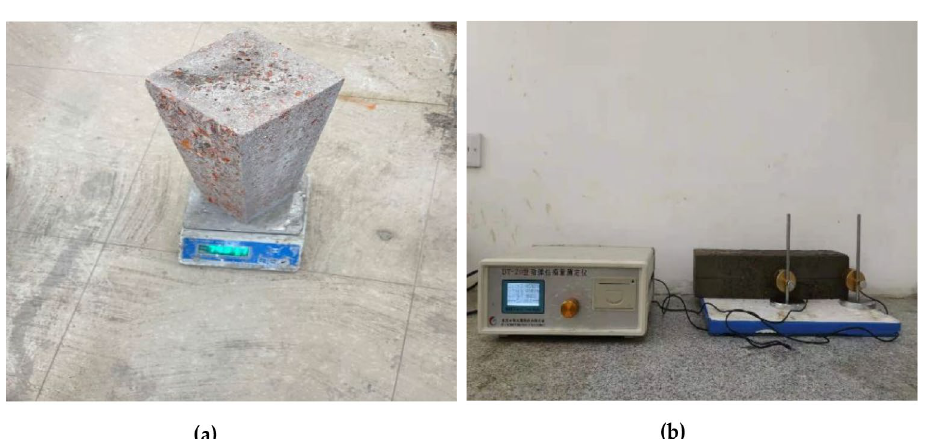
Figure 4. Mass loss rate and modulus of elasticity test: ( a ) Quality loss test; ( b ) Modulus of elasticity test.